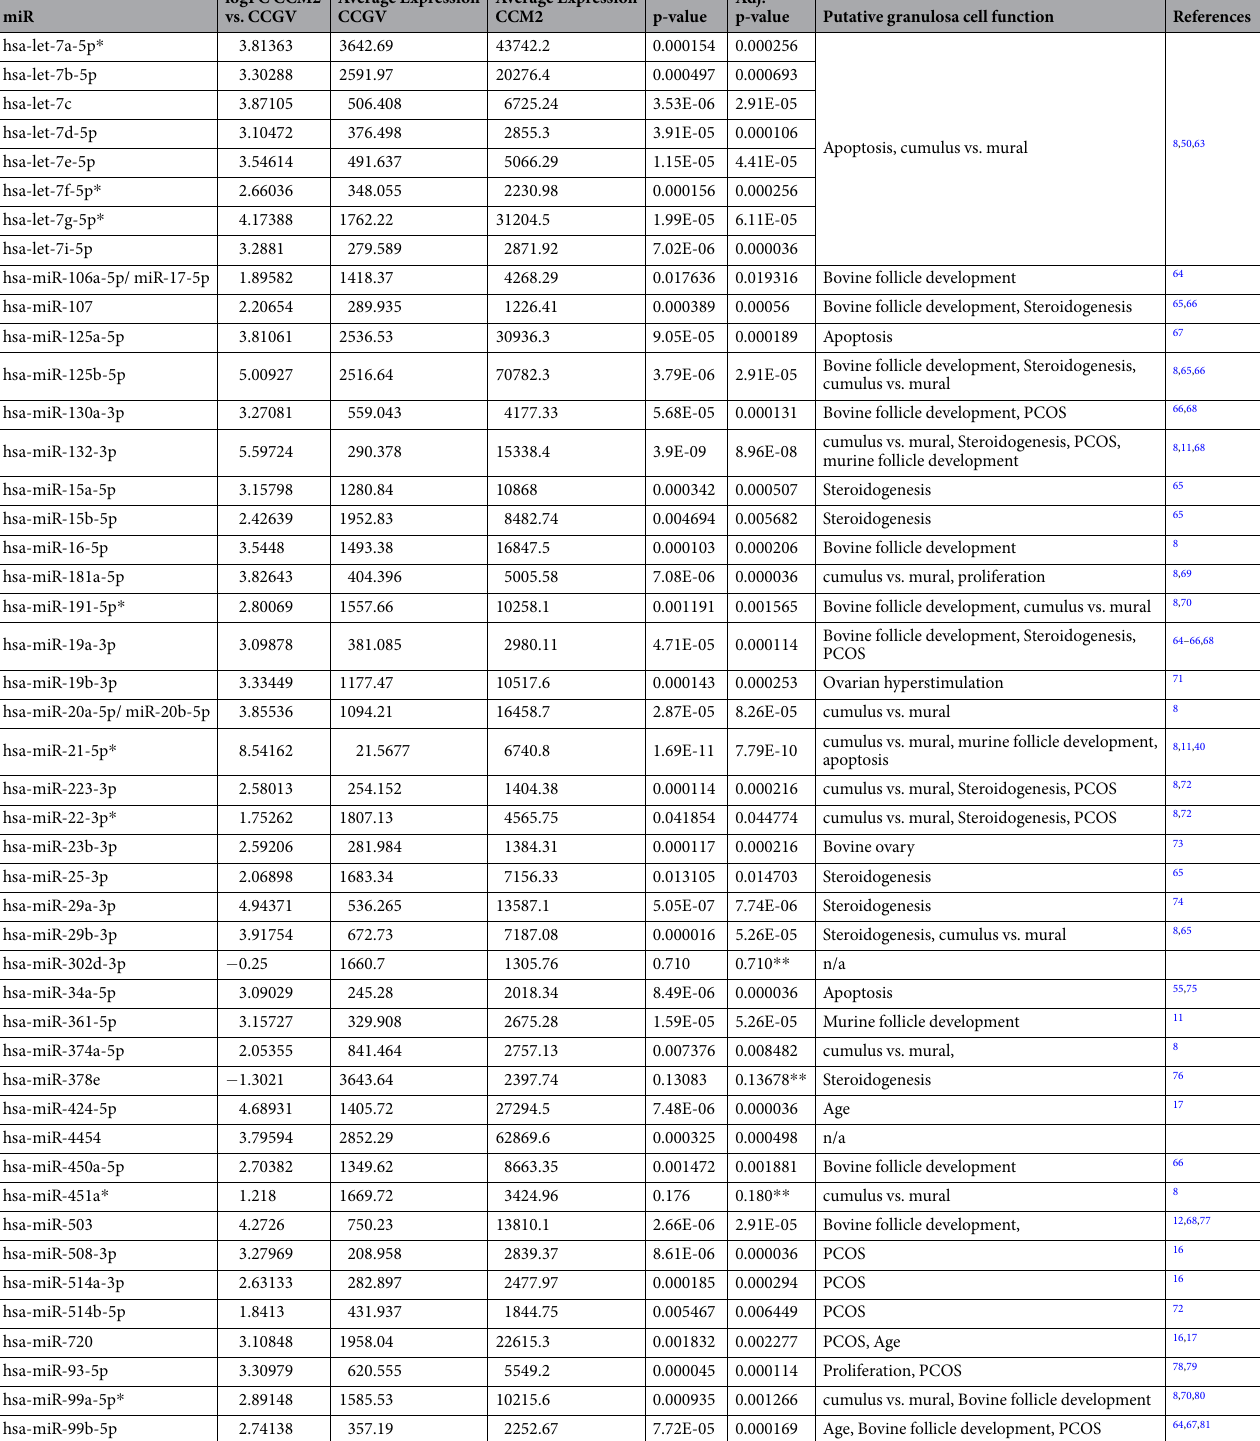
Table 1. miRNAs identified by the NanoString nCounter miRNA expression assay in human cumulus granulosa cells. Forty-three of the miRNAs were differentially expressed with a fold change > 2 and an FDR < 5%. * miRNA detected as one of the 10 most abundant in human cumulus cells 8 . ** Differential expression between CCGV and CCM2 samples was not